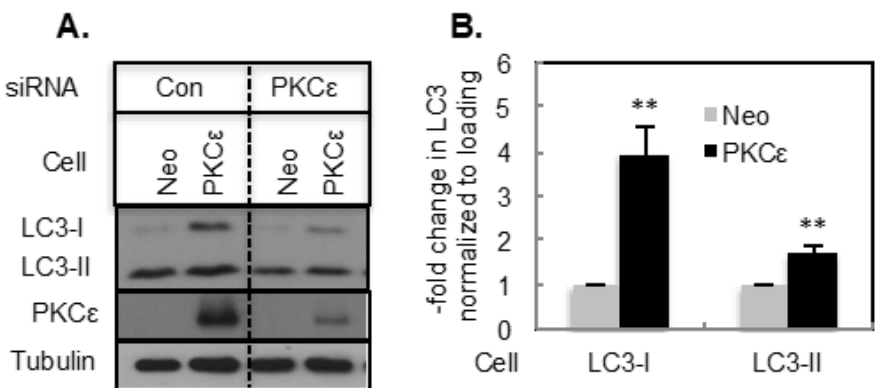
Figure 2. Overexpression of PKC ε increased LC3-I and LC3-II. ( A ) Western blot analysis was performed in MCF-7 cells stably transfected with a vector containing neomycin without (Neo) or with a PKC ε construct (PKC ε ) and transfected with control or PKC ε siRNA. ( B ) Bar graph represents mean ± S.E of LC3-I and LC3-II levels **, p ≤ 0.005 ( n = 9). The comparison was made between MCF-7/Neo and MCF-7/PKC ε cells.